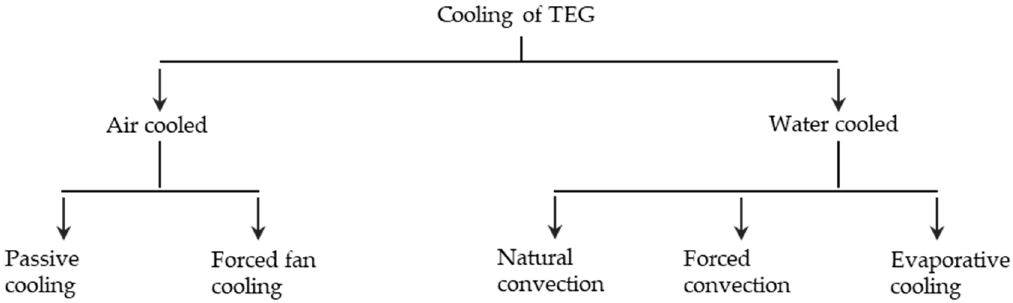
Figure 8. Schematic of an evaporative cooling system for TEG.